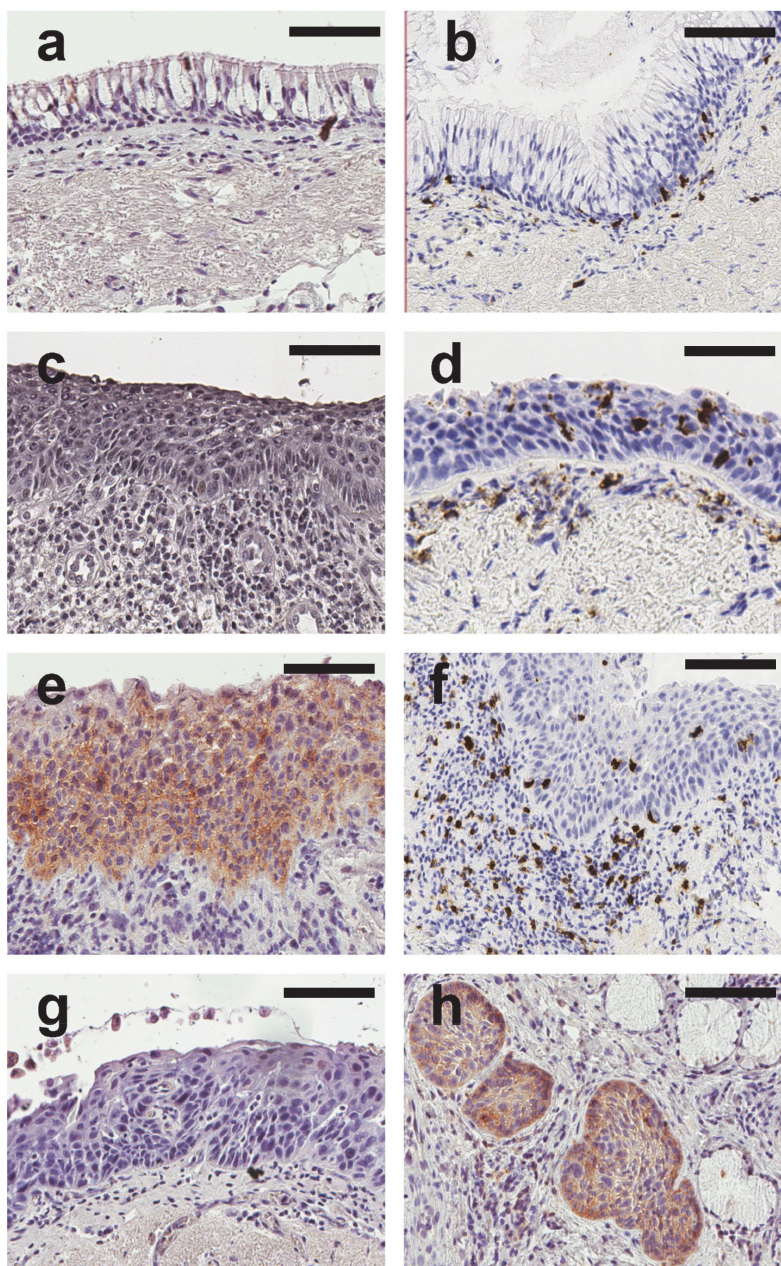
Figure1. RepresentativeimagesofPD-L1andCD8staininginnormal,metaplasticanddysplasticepithelium. All images were taken at × 200 of magnification. Scale bar = 100 µ m. ( a ) Immunohistochemistry anti-PD-L1 in normal bronchial epithelium showing that epithelial cells are not stained. ( b ) Immunohistochemistry anti-CD8 in normal bronchial epithelium showing a staining of scattered lymphocytes in the submucosa. ( c ) Immunohistochemistry anti-PD-L1 in bronchial metaplasia showing that epithelial cells are not stained. ( d ) Immunohistochemistry anti-CD8 in bronchial metaplasia showing staining of intraepithelial lymphocytes and lymphocytes in the submucosa. ( e ) Immunohistochemistry anti-PD-L1 in bronchial dysplasia showing a staining of dysplastic cells in this case of moderate dysplasia. ( f ) Immunohistochemistry anti-CD8 in bronchial dysplasia showing staining of intraepithelial lymphocytes and lymphocytes in the submucosa. ( g ) Immunohistochemistry anti-PD-L1 in bronchial dysplasia showing that none of the dysplastic cells are stained. ( h ) bronchial glands colonization by PD-L1 positive dysplastic cells without stromal invasion in a case of high grade